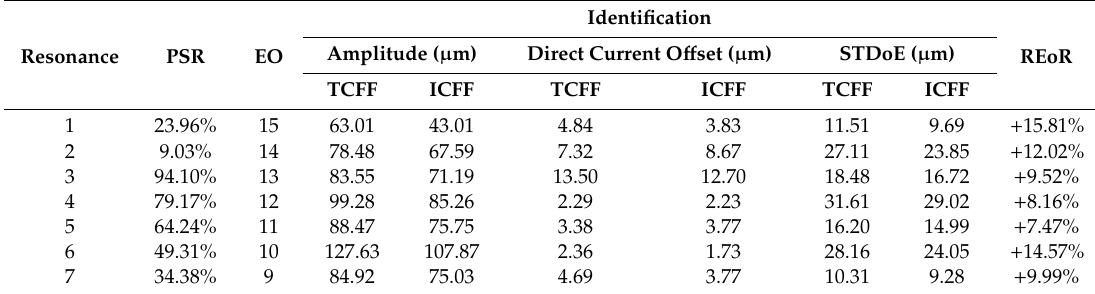
Table 5. The results of the